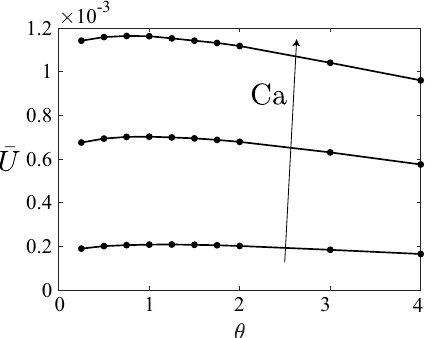
Figure 6. Average velocity of the micro-rocket versus the cone angle θ for Ca = [ 0.01,0.05,0.1 ]